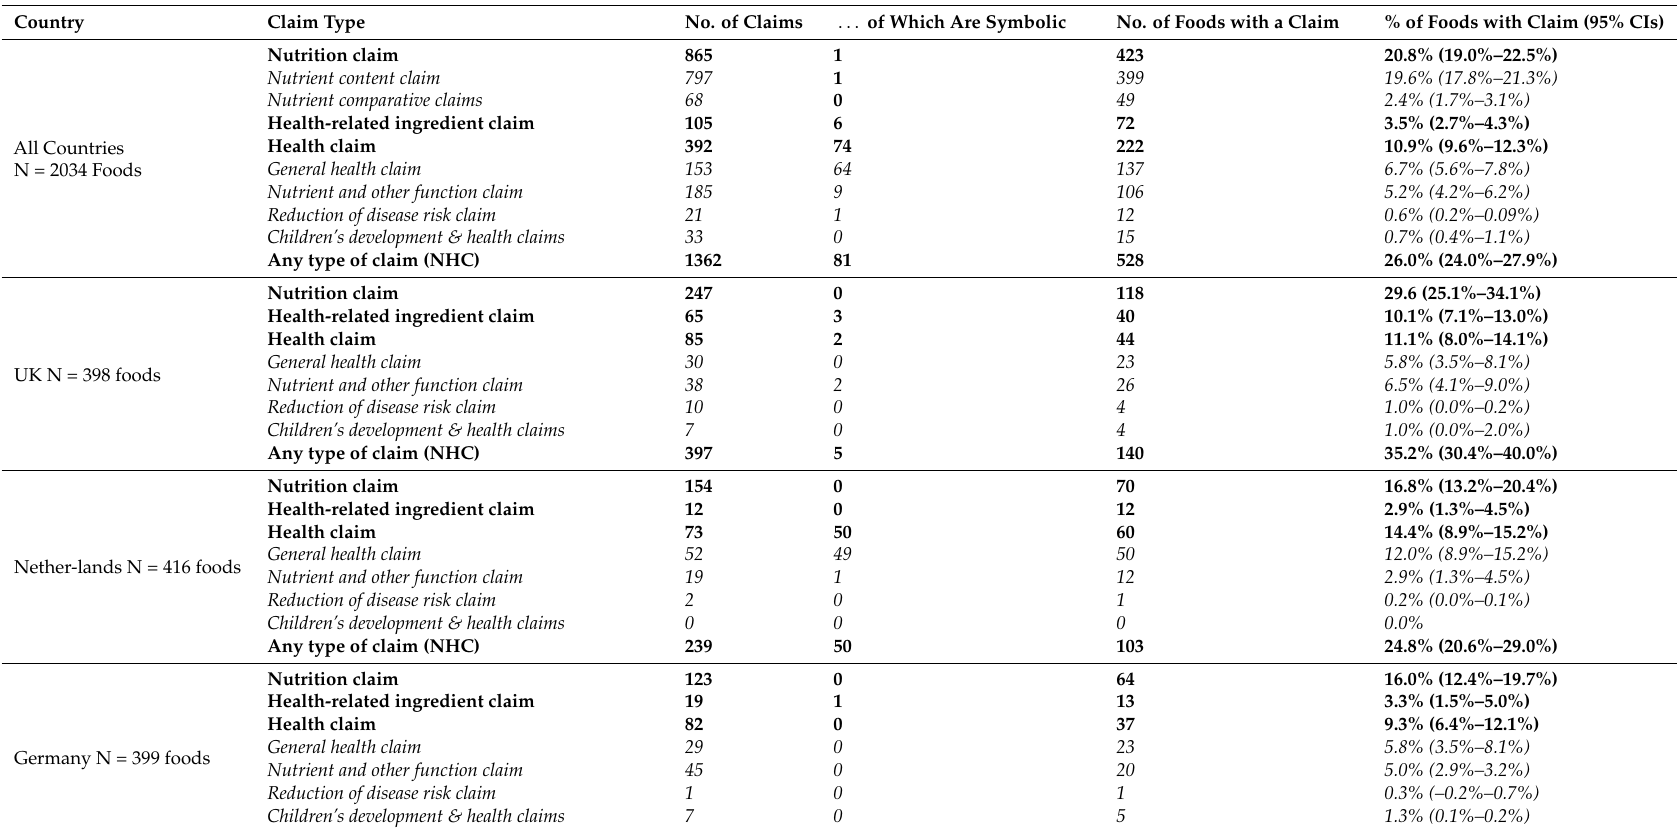
Table 2. Prevalence of nutrition claims, health claims, and symbols in five European